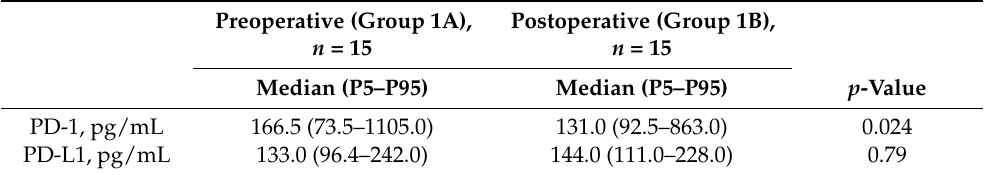
Table 5. Plasma PD-1 and PD-L1 concentrations pre- (group 1A) vs postoperative (group 1B) in patients undergoing radical resection for GIST .